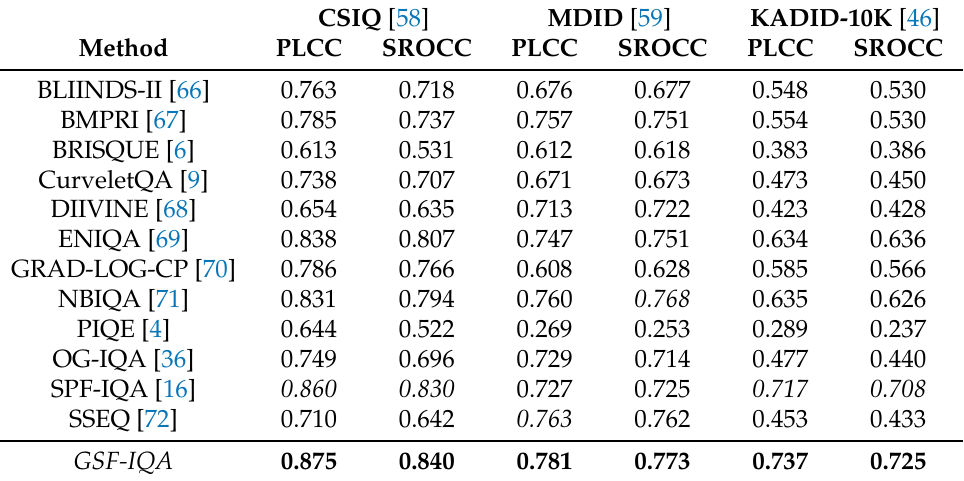
Table 5. Comparison of GSF-IQA to the state-of-the-art on artificial distortions. Mean PLCC and SROCC are measured over 100 random train–test splits with respect to the reference images. Best results are typed in bold, second best results are typed in